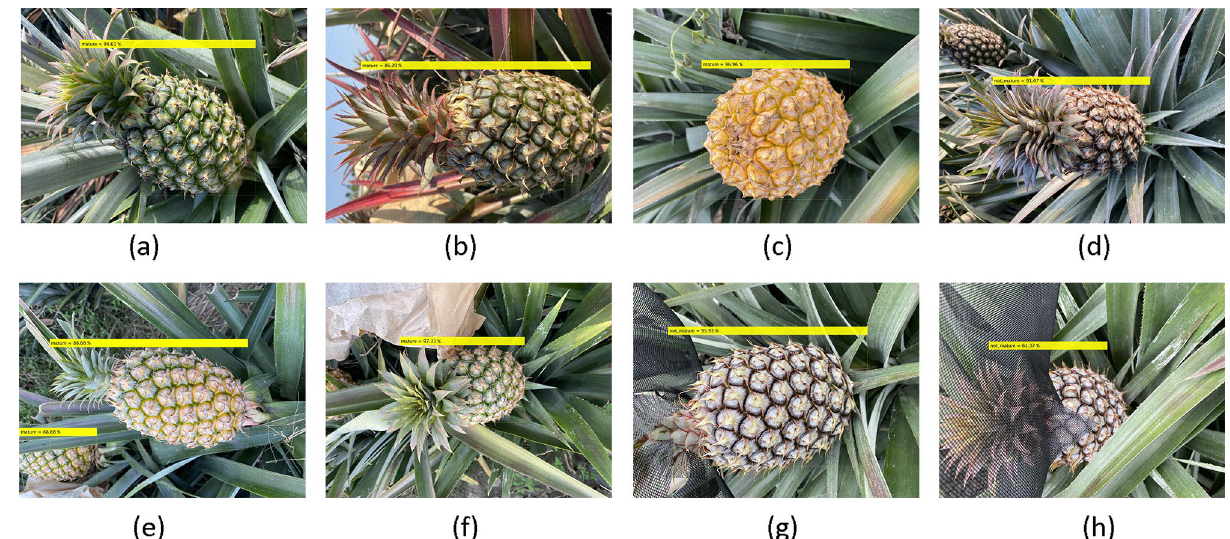
Figure 1. Experiment results: ( a – d ) training images; ( e – h ) test images.